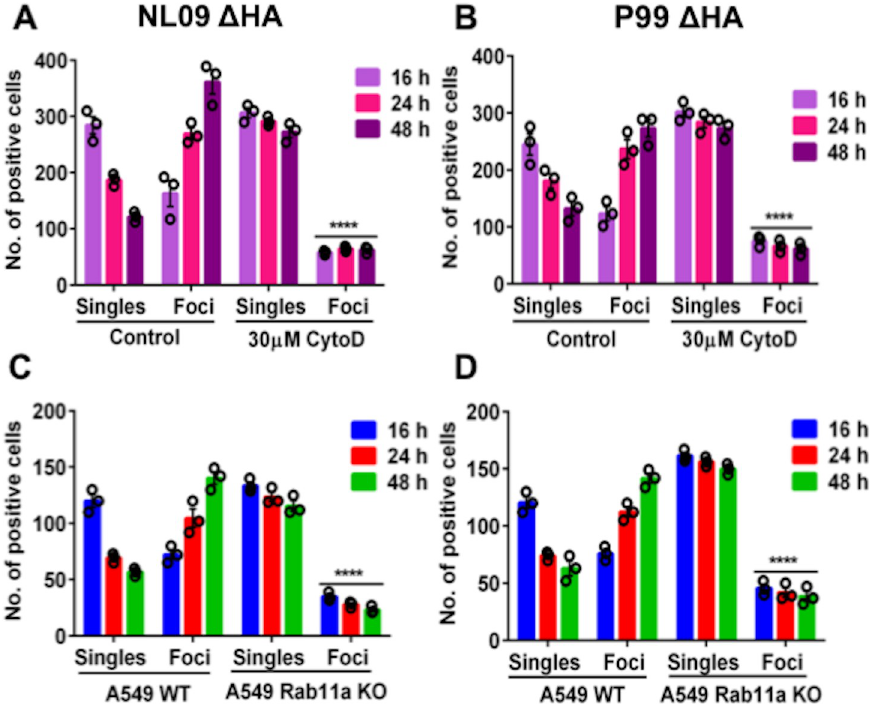
Fig 4. Disruption of actin or loss of Rab11a abrogates direct cell-cell transmission of infection. MDCK cells infected with NL09 Δ HA Venus WT [A] or P99 Δ HA Venus WT [B]at a MOI of 0.5 were counted as single infected cells or foci of infected cells. Significance of differences in the number of infected foci between the control and Cytochalasin D treated groups was tested using 2-way ANOVA with Bonferroni’s correction for multiple comparisons [ ���� P-value < 0.0001]. Error bars represent the standard error of three biological replicates. A549 WT or A549 Rab11a KO cells infected with NL09 Δ HA Venus WT [C] or P99 Δ HA Venus WT [D] at a MOI of 0.5 were counted as single infected cells or foci of infected cells.Significance of differences in the number of infected foci between cell types was tested using 2-way ANOVA with Bonferroni’s correction for multiple comparisons [ ���� P-value < 0.0001]. Error bars represent the standard error of three biological